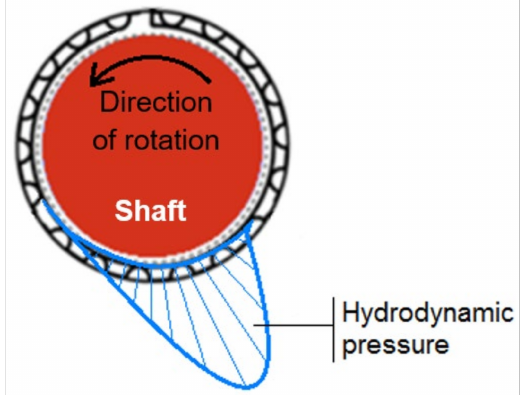
Figure 2. Approximate representation of the hydrodynamic pressure in a